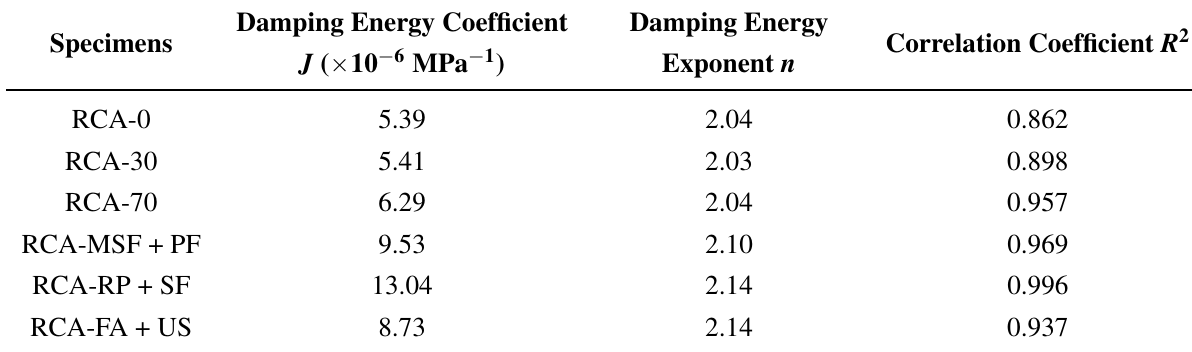
Table 8. Damping energy coefficient and exponent of recycled aggregate